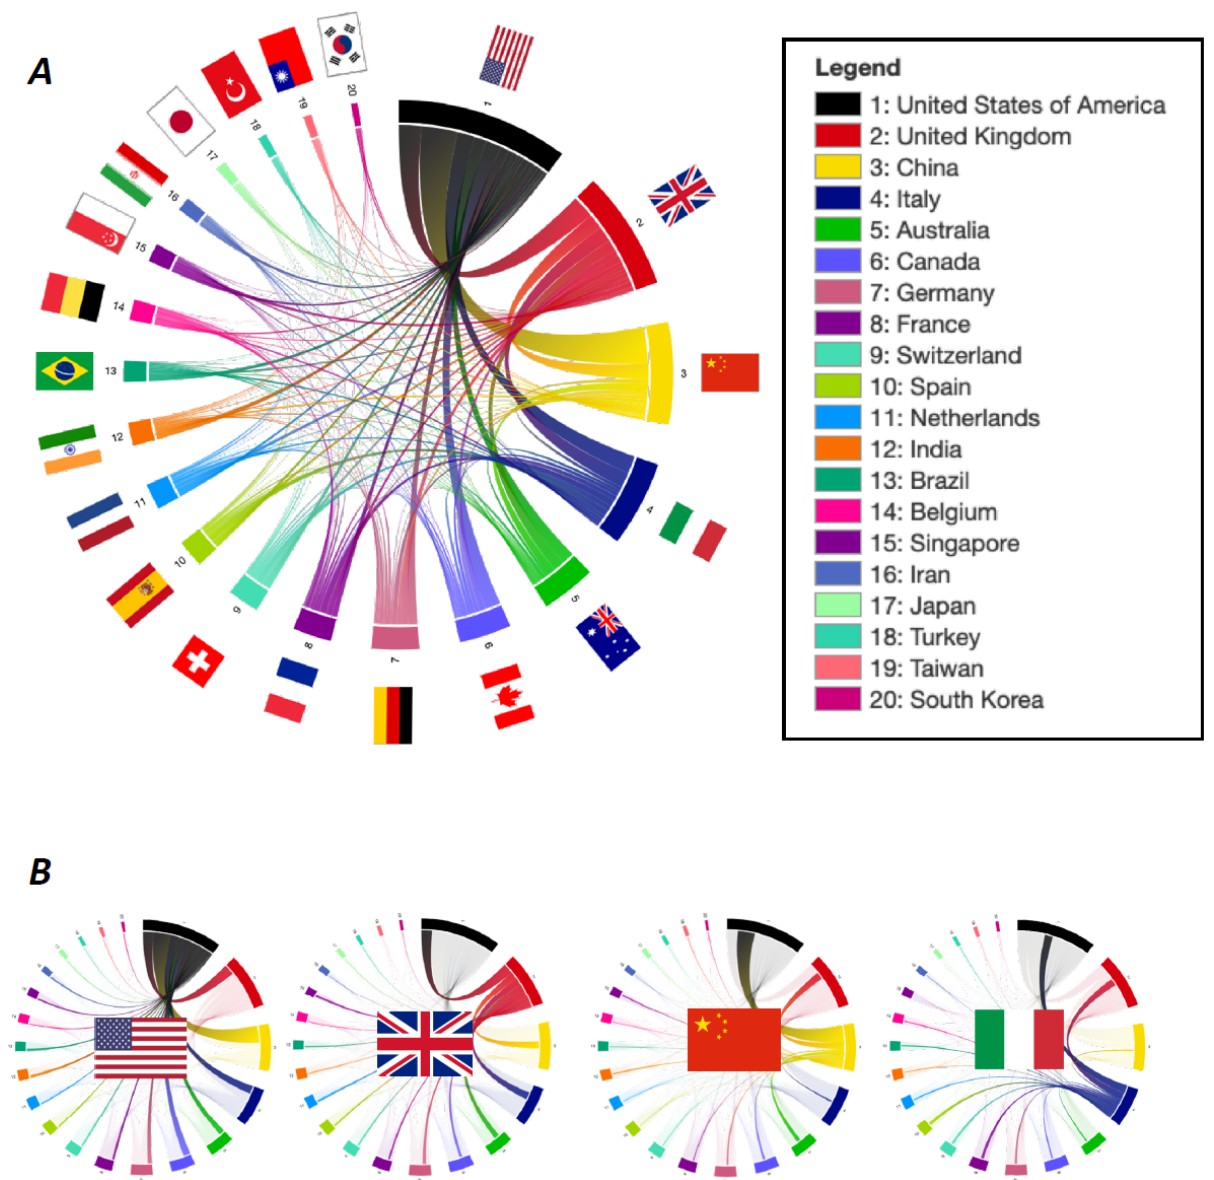
Figure 3. (A) Research collaborations identified by joint publications. Each edge corresponds to a joint publication between the connected countries. (B) Leading countries—United States, United Kingdom, China, and Italy—in the cooperation